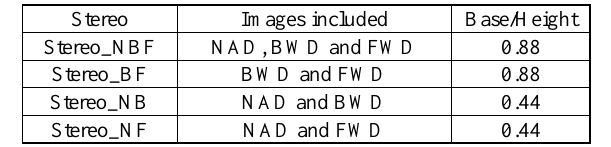
Table 3. The ZY-3 stereo triplet and stereo